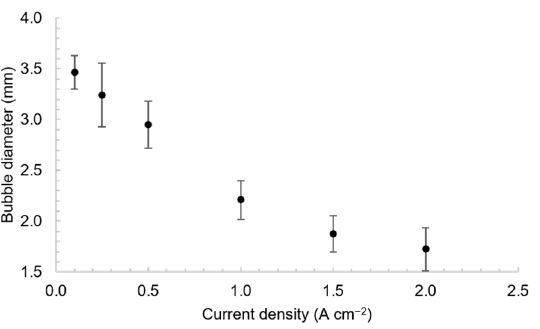
Figure 17. Bubble diameter after detachment from the vertical surface as a function of nominal current density.